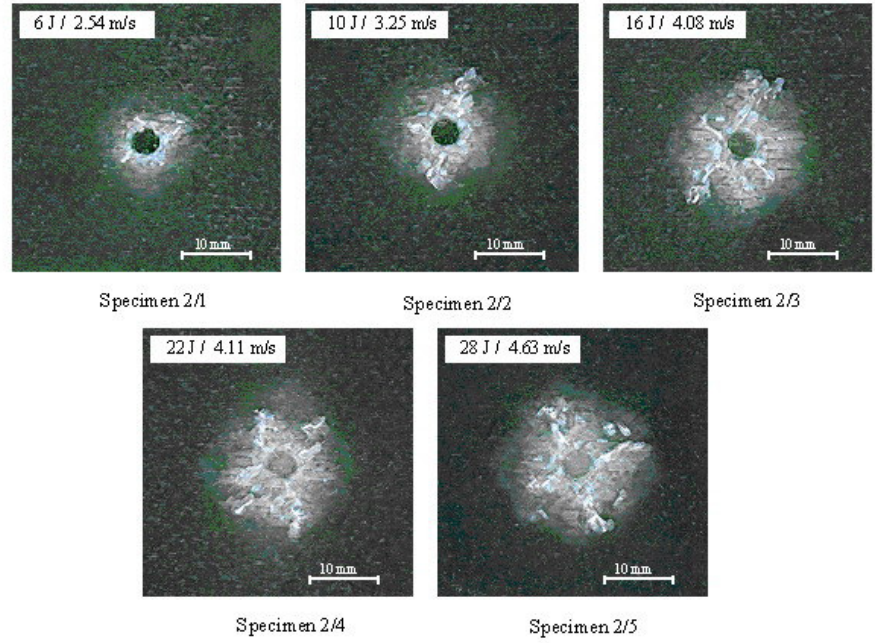
Fig 4. Front face view of woven glass-fiber reinforced composites showing damage modes at impact energies between 16 and 28 J and impact velocities between 2.54 and 4.63